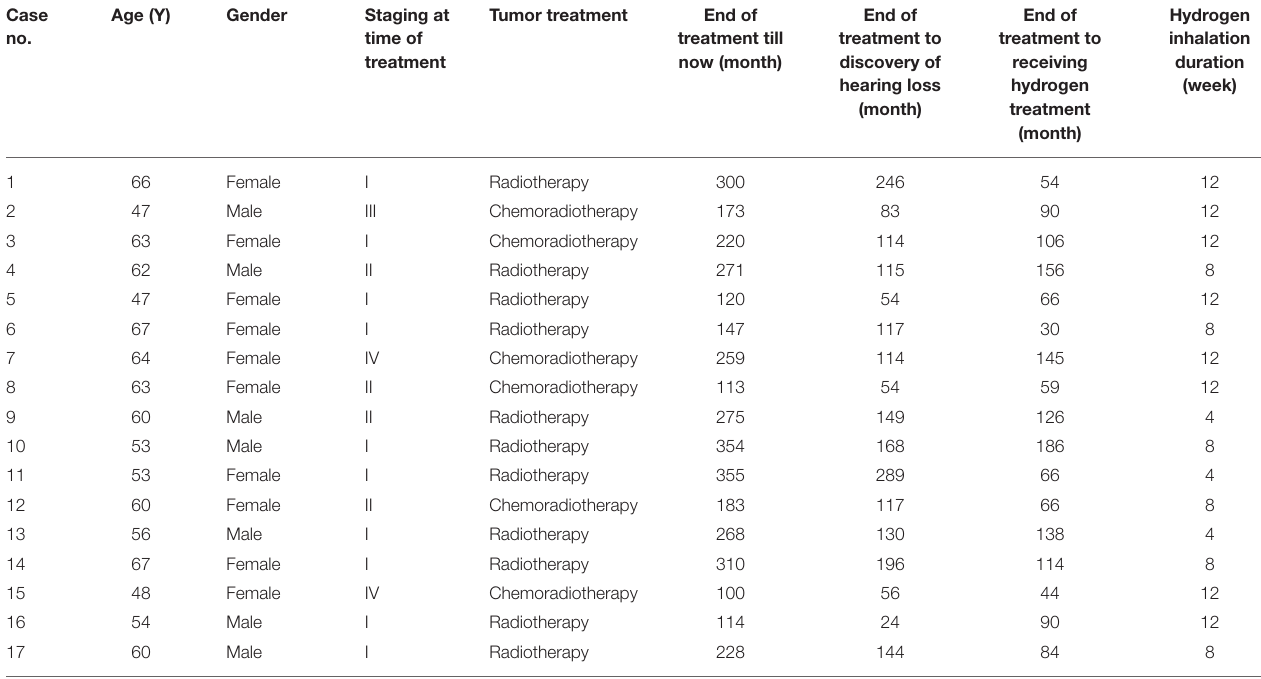
TABLE 1 | Basic information of the 17 patients with hearing loss after nasopharyngeal carcinoma radiotherapy/chemoradiotherapy. Case no.